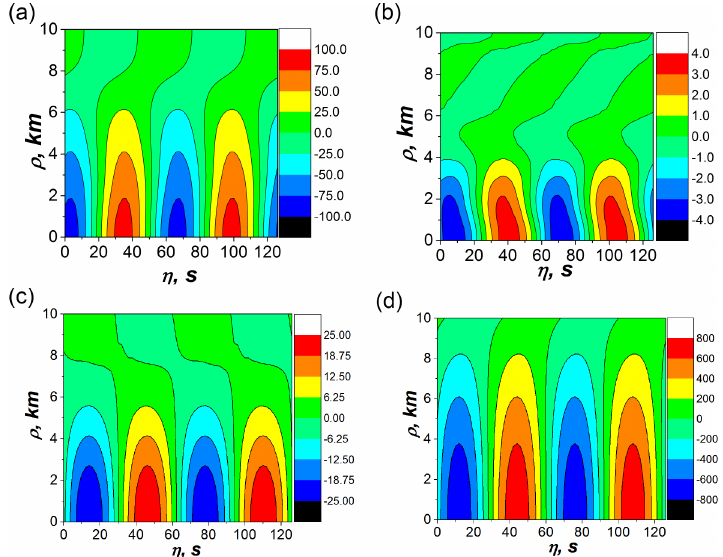
Figure 3. Spatial distribution of the air velocity v in ULF AGWs (cms − 1 units) for different parameters. Panels (a) and (d) are for the double frequency transforms 600Hz → 25Hz → 0.016Hz, panel (c) is for 600Hz → 100Hz → 0.016Hz, and panel (b) is for the single frequency transform 25Hz → 0.016Hz. Panels (a) , (b) , and (c) are for an initial transverse SW width of 1m. Panel (d) is for an initial transverse SW amplitude of 2.5m. Panel (a) is for an initial transverse SW amplitude of 320ms − 1 ; and panels (b) , (c) , and (d) are for an initial transverse SW amplitude 420ms − 1 . Panels (a) and (d) are for an altitude of Z = 300km; panels (b) and (c) are for an altitude of Z =